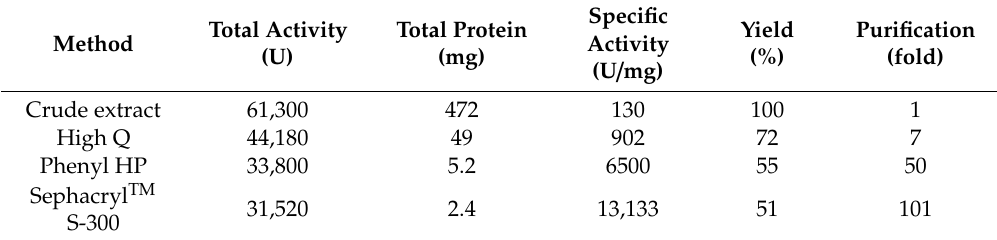
Table 1. Purification of recombinant enzyme Cobetia marina ALP (CmAP) from E. coli BL21 (DE3).